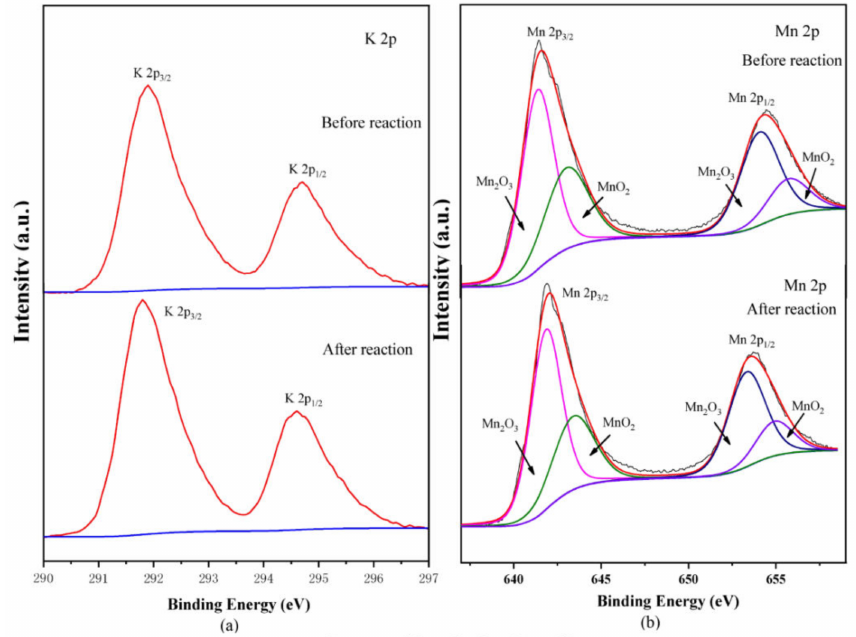
Figure 7. XPS spectra of Co 0.3 -OMS-2: ( a ) K2p, ( b )